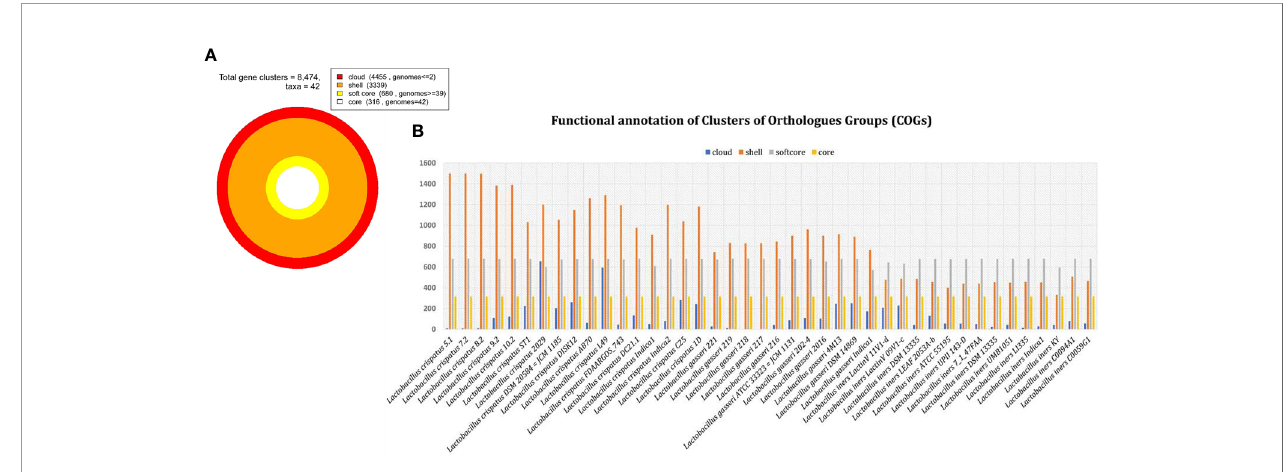
FIGURE 3 | Distribution of orthologous gene clusters. (A) Total gene cluster and its distribution in cloud, shell, soft core and core part of genome among 42 genomes. (B) The bar graph of individual genome in cloud, shell, soft core and core